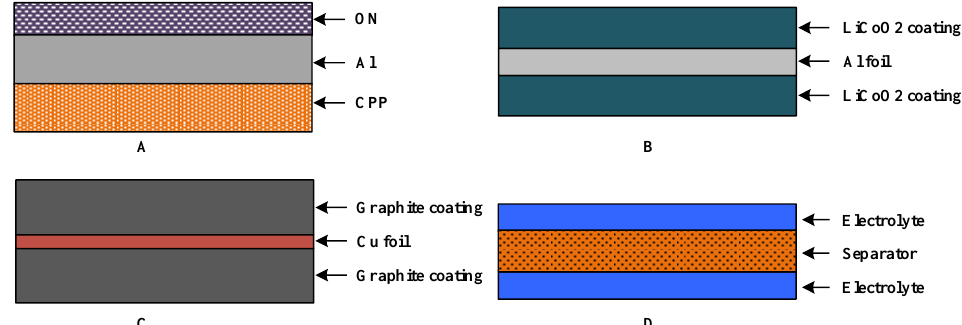
Figure 2. The composition of a lithium-ion battery.